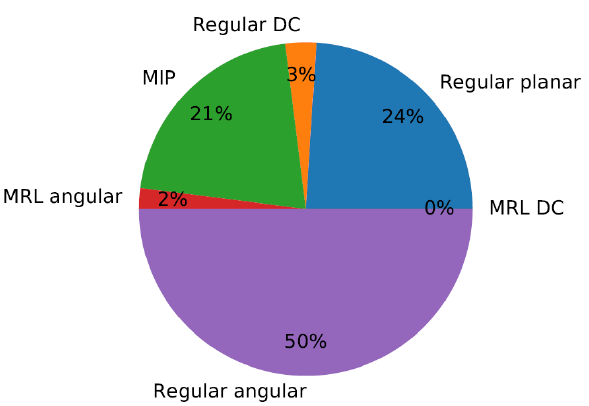
Figure 7. Distribution of training dataset.